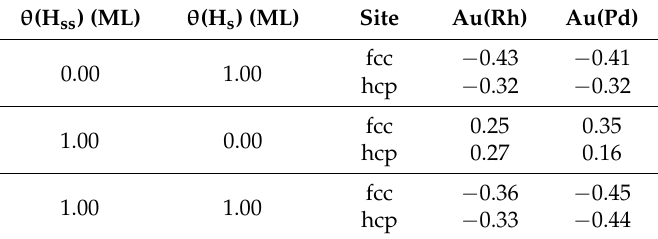
Table 6. Delta work function ΔΦ for single hydrogen ab/adsorption and for both species simultaneously. In each case the reference is the work function of the corresponding clean alloy surface. All the values are in eV.